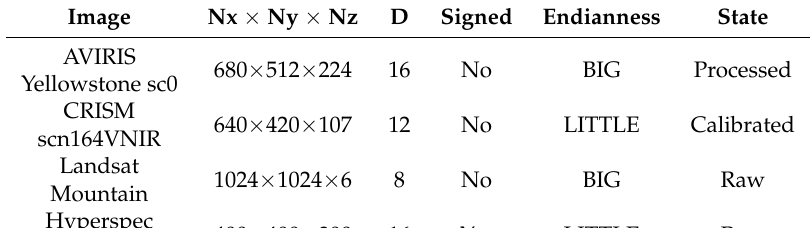
Table 5. Images to validate the algorithm implementation.